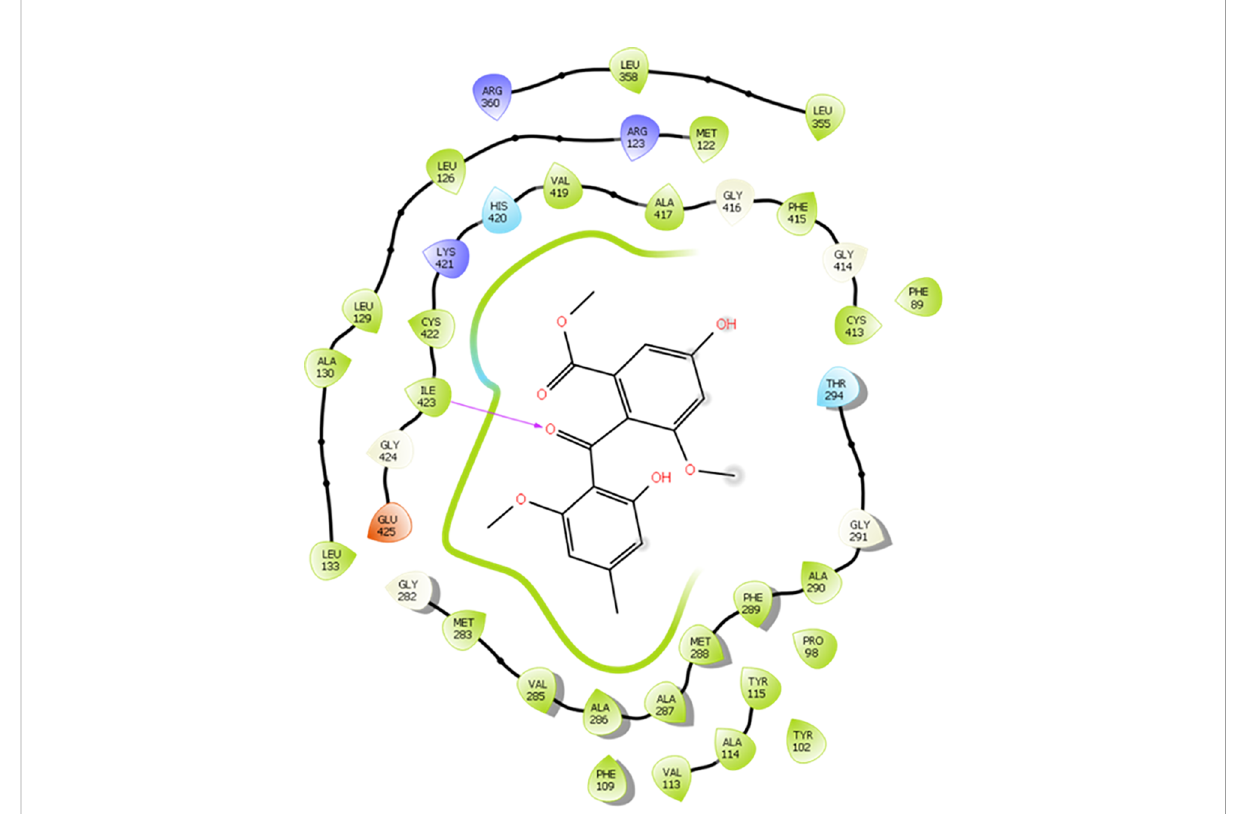
FIGURE 7 2D diagram of the interaction of monomethylsulochrine at the active site of CYP51 (PDB ID 3TIK). Hydrogen bonds are shown as arrows in purple, hydrophobic interactions in green lines, and polar interactions in light blue